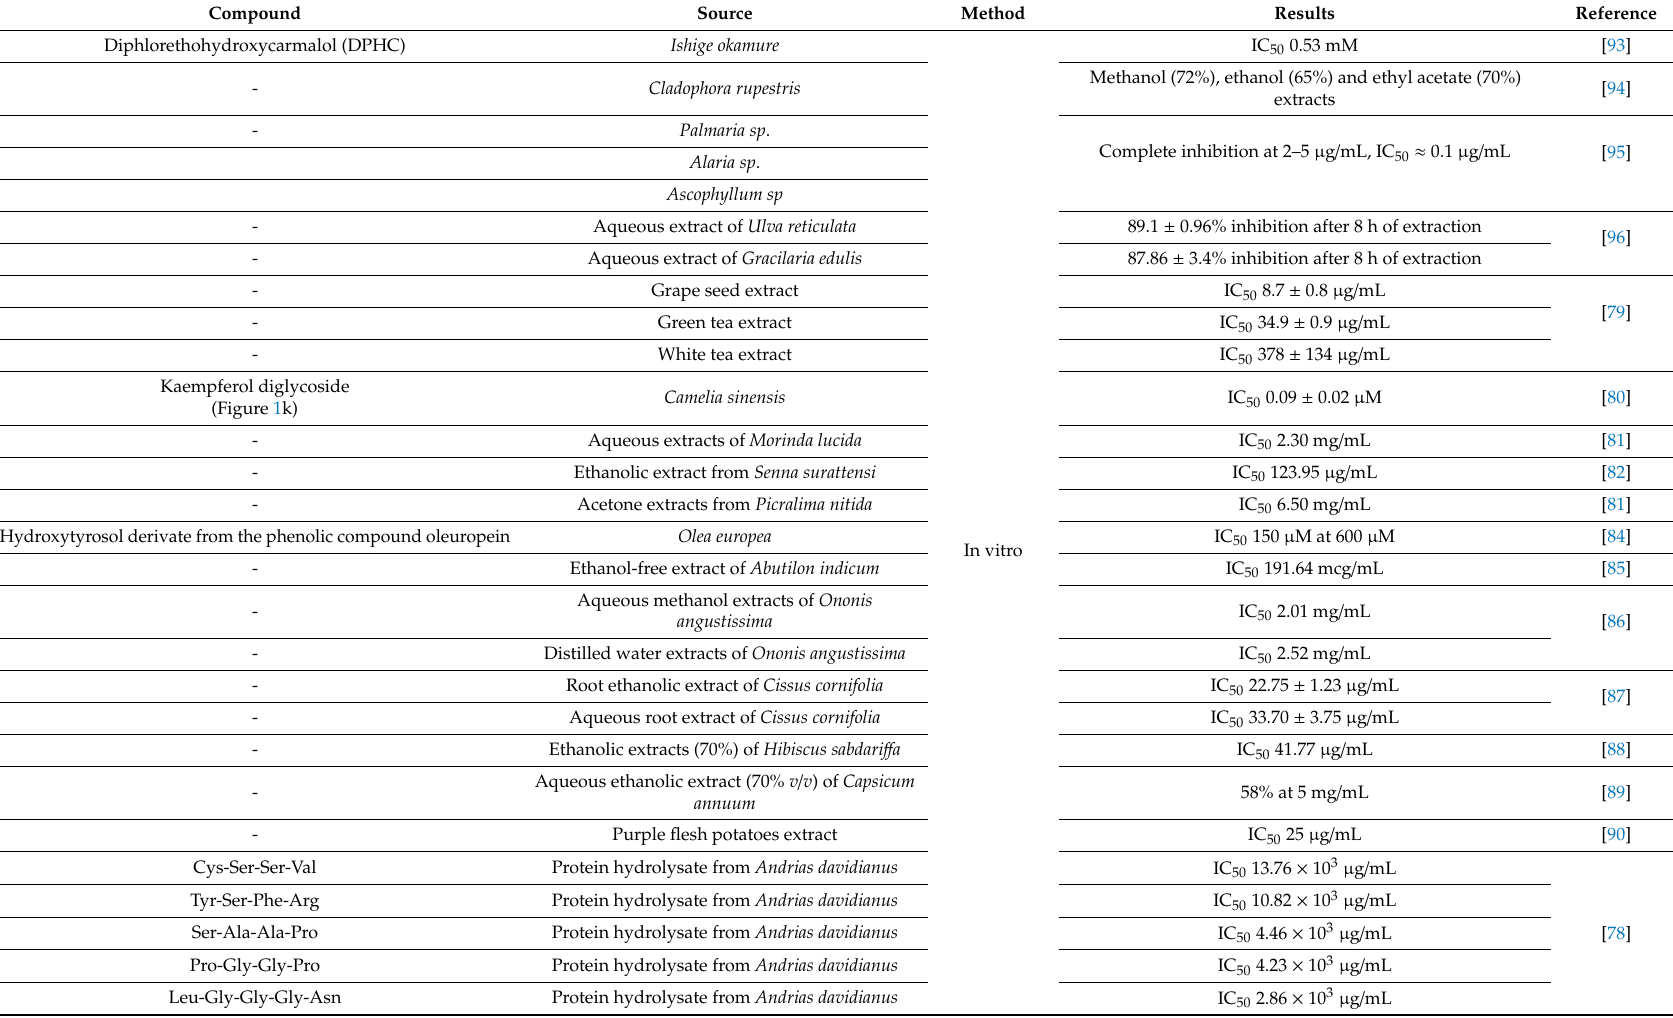
Table 4. Natural alpha-amylase